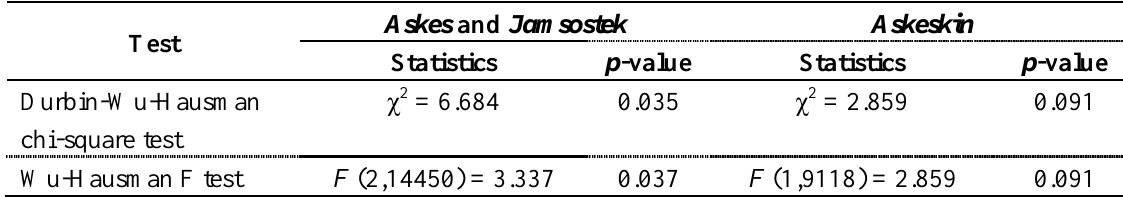
Table 5. Endogeneity tests.